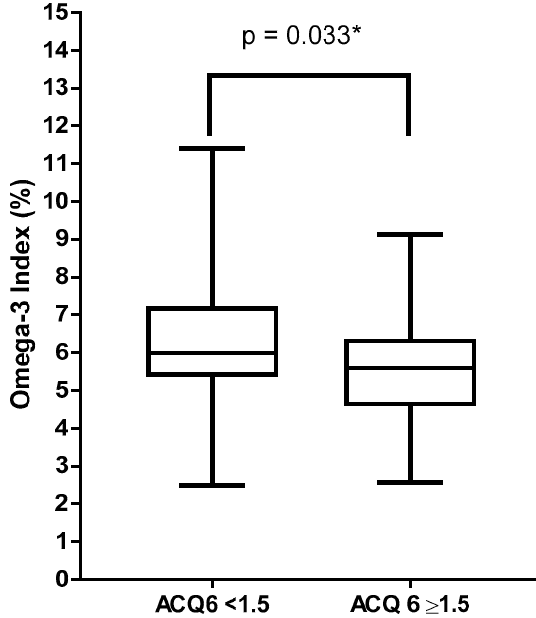
Figure 1. Omega-3 index classified by asthma control, ACQ < 1.5 n = 150, ACQ ≥ 1.5 n = 44. * Logistic regression adjusting for age, BMI and gender.